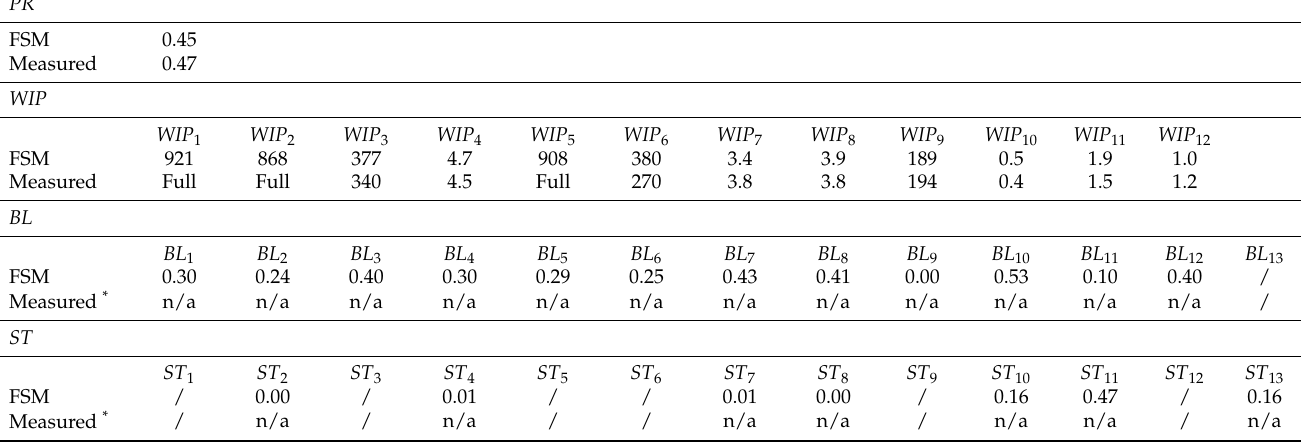
Table 4. Comparison of the determined key performance indicators with those acquired on the factory